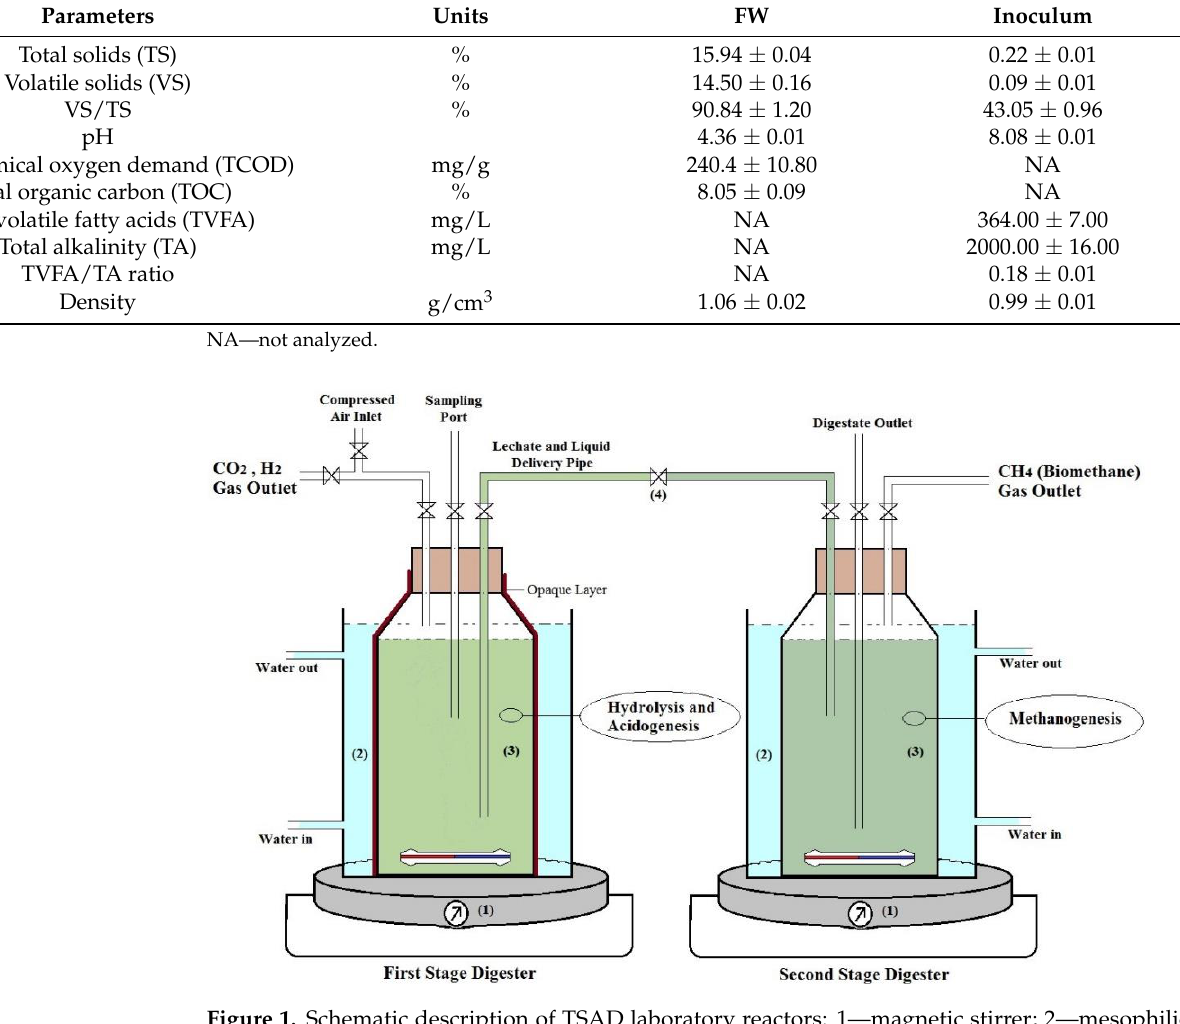
Figure 1. Schematic description of TSAD laboratory reactors: 1 — magnetic stirrer; 2 — mesophilic water circulation bath maintained at 35 °C; 3 — serum bottle as CSTR reactors; 4 — flow Controllers.